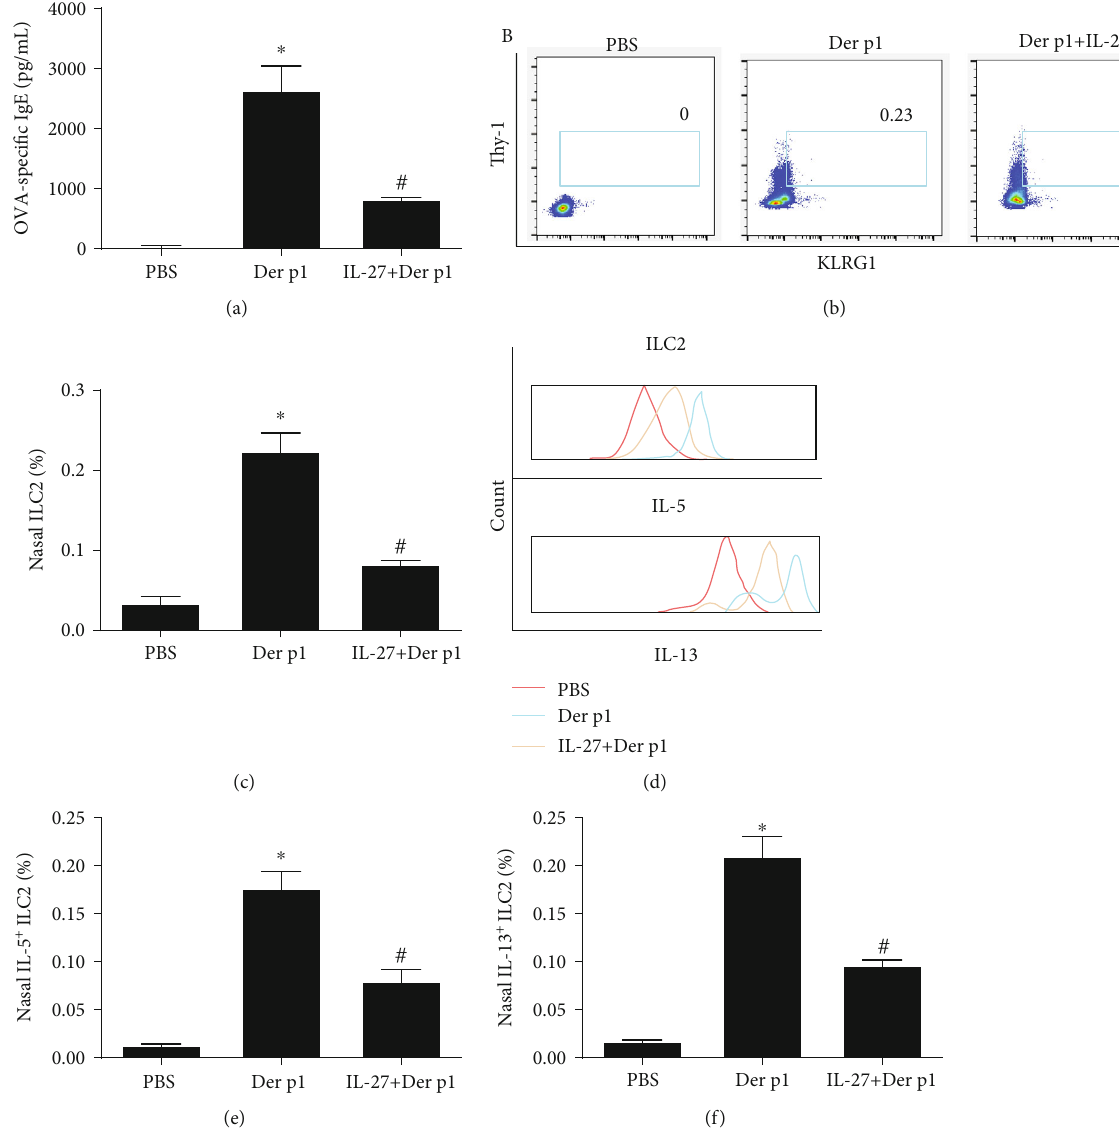
Figure 5: IL-27 inhibits allergic responses in mouse model. (a) Levels of Der p1-speci fi c IgE by enzyme-linked immunosorbent assay after IL- 27 stimulation. (b, c) The proportions of nasal ILC2 in total cells of inferior turbinate tissue after IL-27 treatment by fl ow cytometry. (d – f) The proportions of nasal IL-5+ILC2 and IL-13+ILC2 in total cells of inferior turbinate tissue. After IL-27 treatment by fl ow cytometry. Ten mice were allocated into every group. Three independent tests were performed for every experiment. ∗ Compared with PBS, P < 0 : 05 . # Compared with Der p1 (100ng/mL), P < 0 : 05 . OVA: ovalbumin; Der p1: dermatophagoides p1 protein; ILC2: group II innate lymphoid